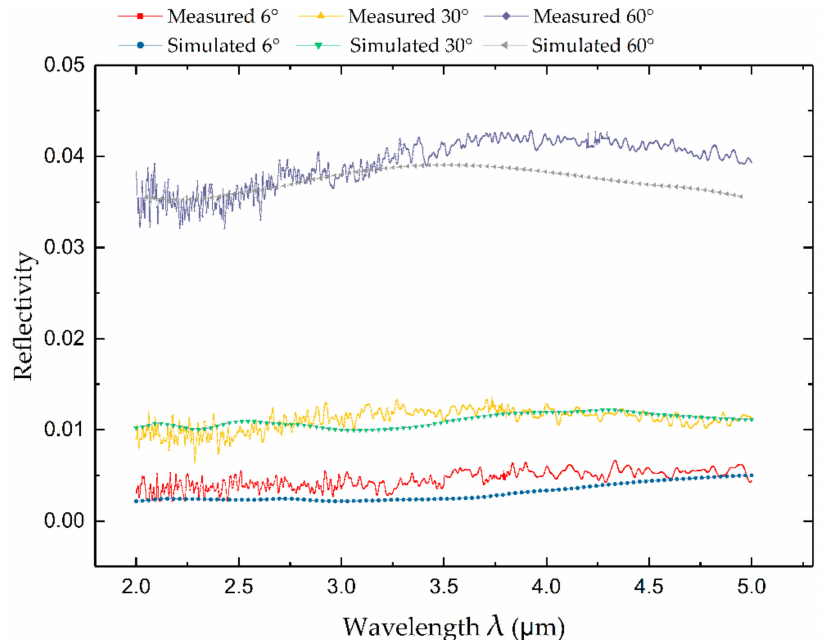
Figure 8. Experimental and simulated reflectivity of moth-eye structure with a waist for broadband and wide-angle. The feature dimension is a circular area with a diameter of 35